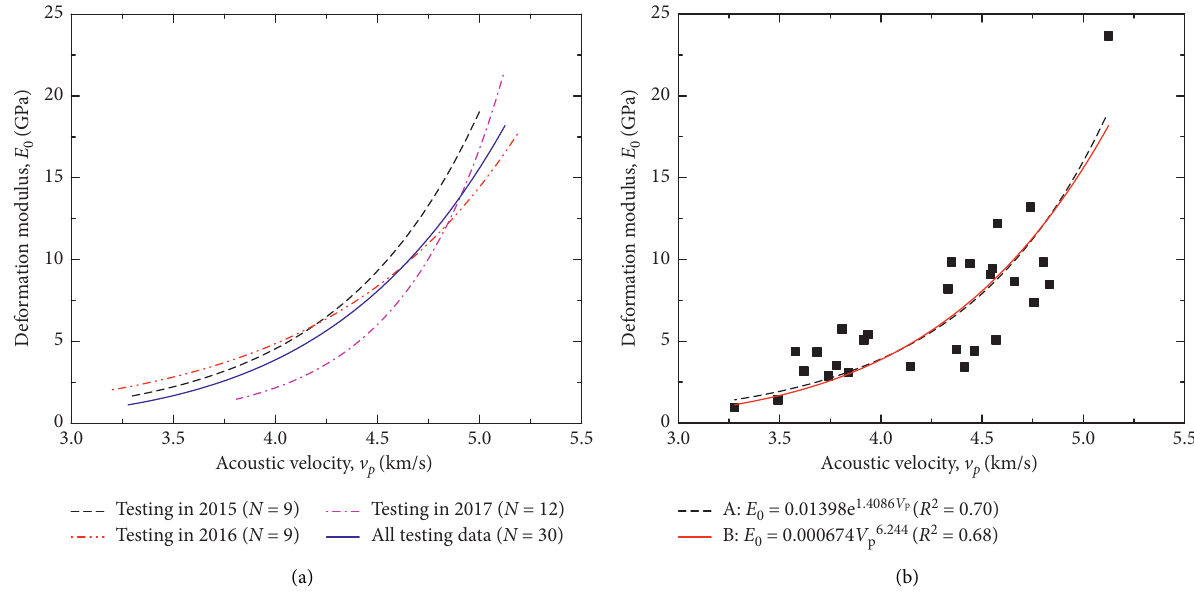
Figure 8: E v p curves of CJB at the left bank in different periods and fitting functions. (a) E 0 - 0 - different fitting functions for E 0 - v p